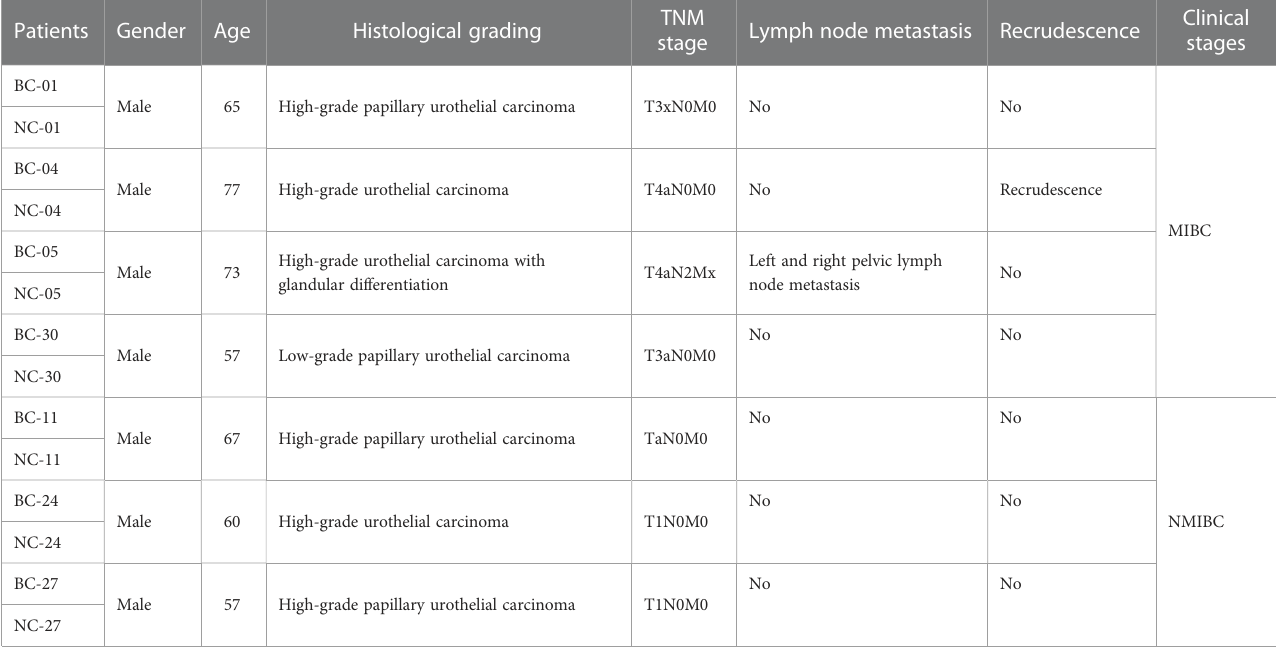
TABLE 1 Clinical information of seven patients (the NC groups were the corresponding normal tissues adjacent to cancer).